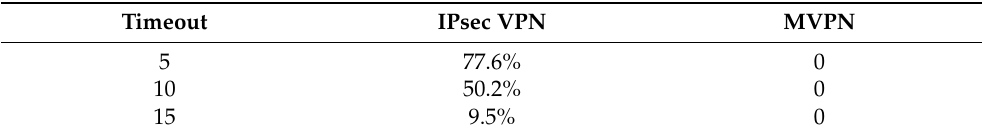
Table 4. Comparison of the success rate of IPsec VPN and MVPN attacks.